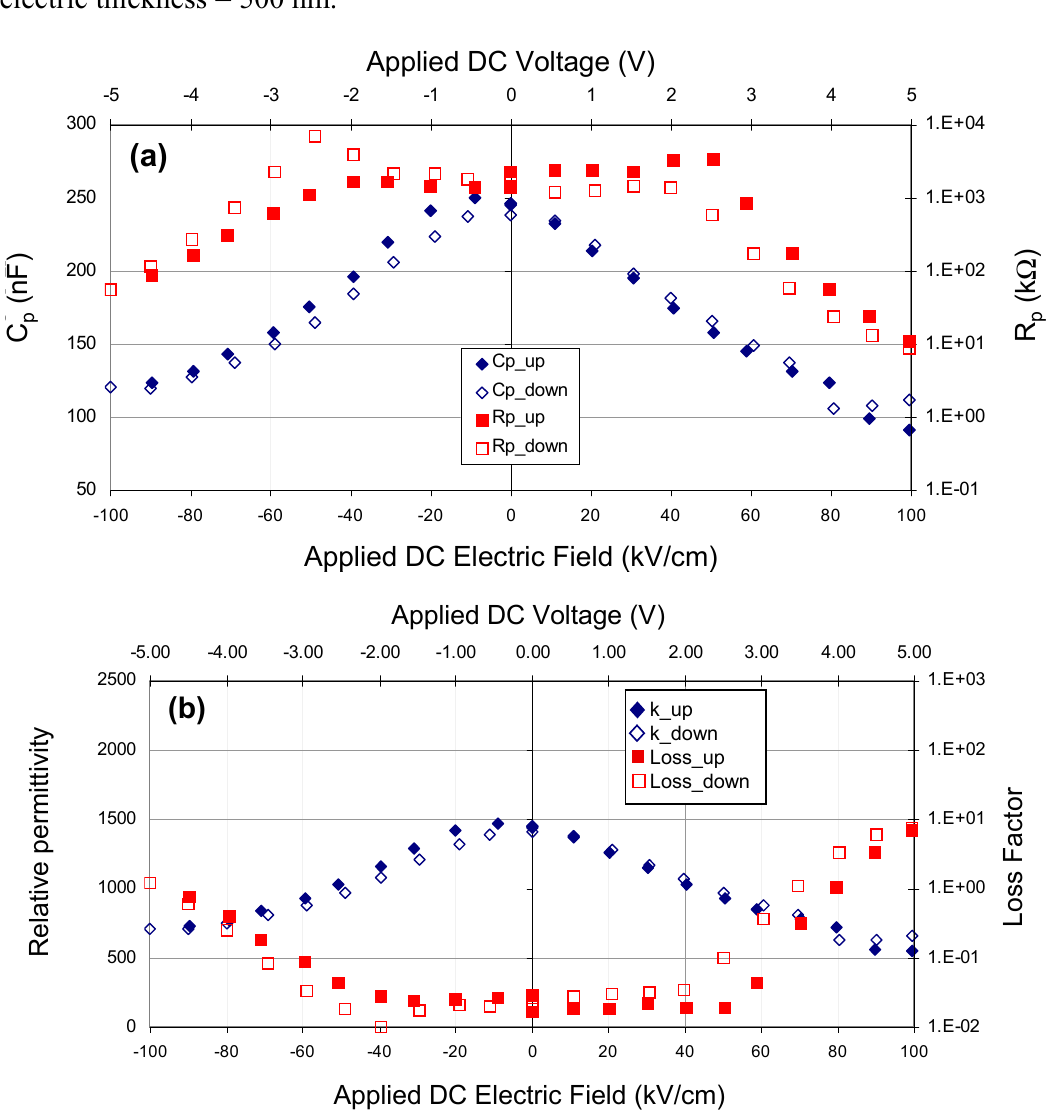
Figure 1. ( a ) Capacitance and resistance and ( b ) relative permittivity and loss factor vs . applied DC bias for a test capacitor fabricated with a Pt bottom electrode, a Ni top electrode and a modified barium titanate dielectric deposited at 900 °C, 10 mtorr pressure and a sputter gas mixture of 10% oxygen/ 90% argon. AC probe voltage = 50 mV@20 Hz, dielectric thickness = 500